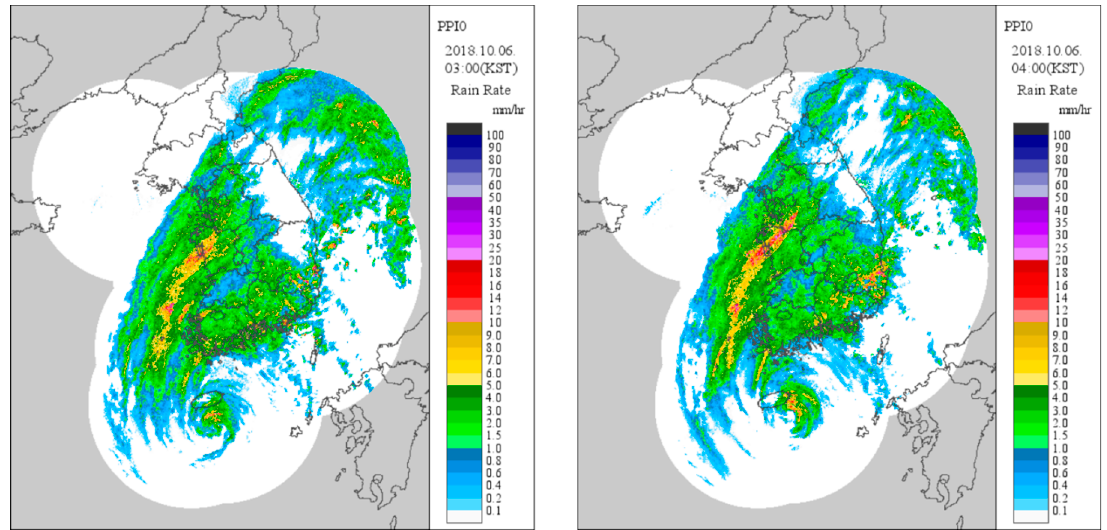
Figure 6. Radar image of KMA ( left ) at 03:00, and ( right ) at 04:00 on 6 October 2018 (KST).